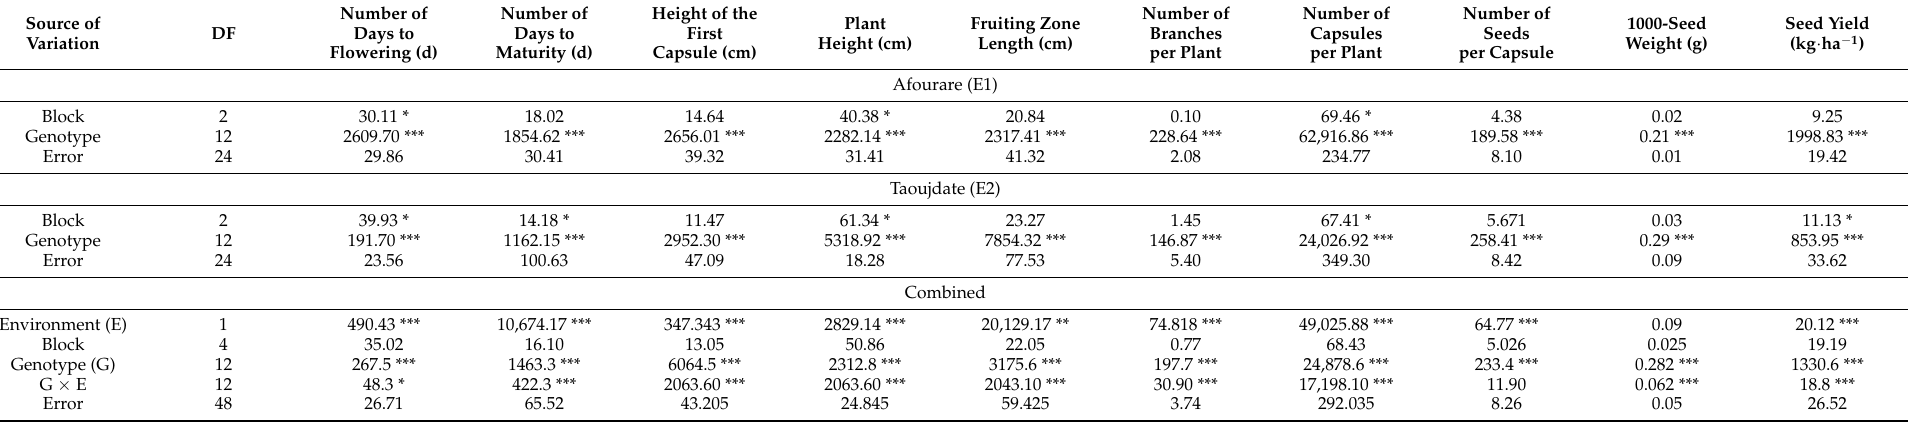
Table 3. Results of individual and combined analysis of variance (mean squares) for ten traits in 13 sesame genotypes evaluated in two environments.